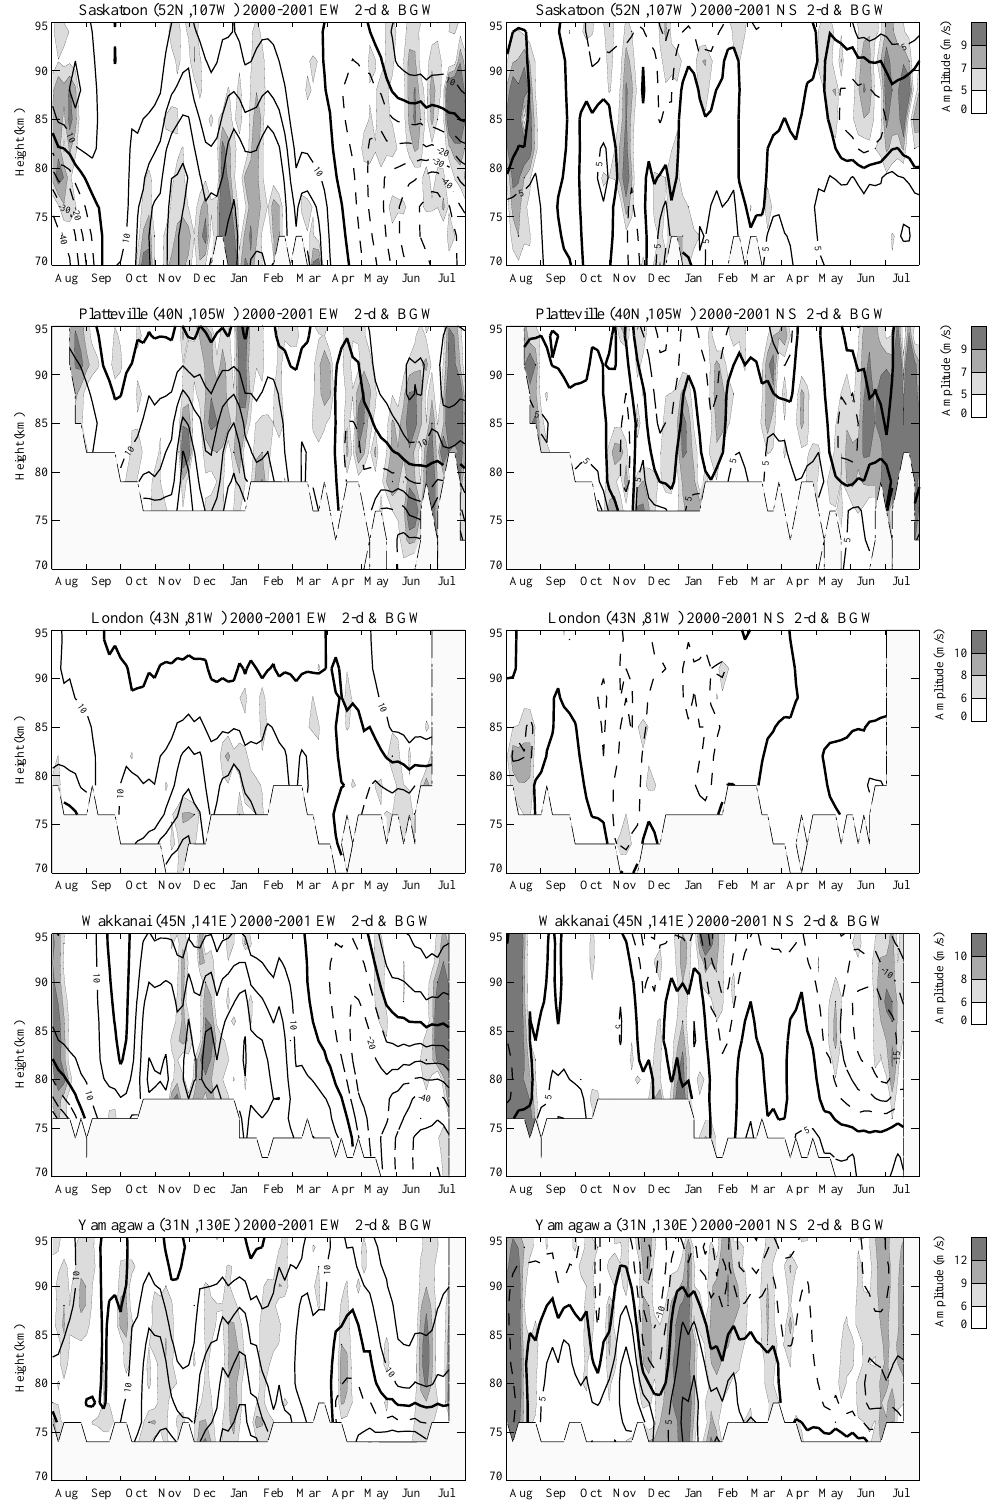
Fig. 7. Annual contours of wave amplitudes as functions of height versus time for the zonal and meridional (EW, NS) components of the 2-d PW: plots for Saskatoon, London, Platteville, Wakkanai and Yamagawa are shown. The background-mean winds are shown by continuous or dashed